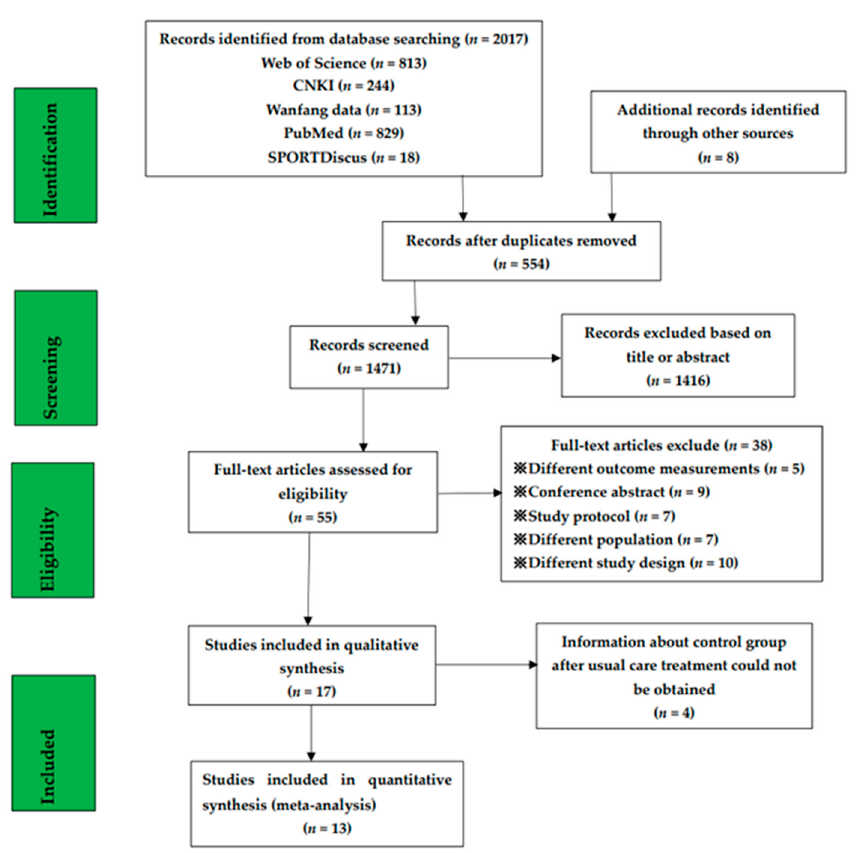
Figure 1. Flow chart of retrieval, screening and inclusion of articles in the systematic review. Table 2. Characteristics of the included